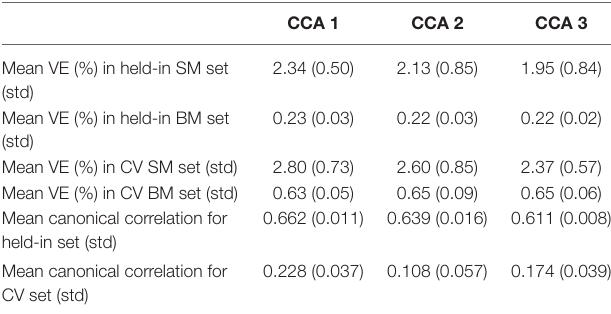
TABLE 4 | Five-fold CV on 62 dimensional SM and 100 dimensional BM in DDR CCA